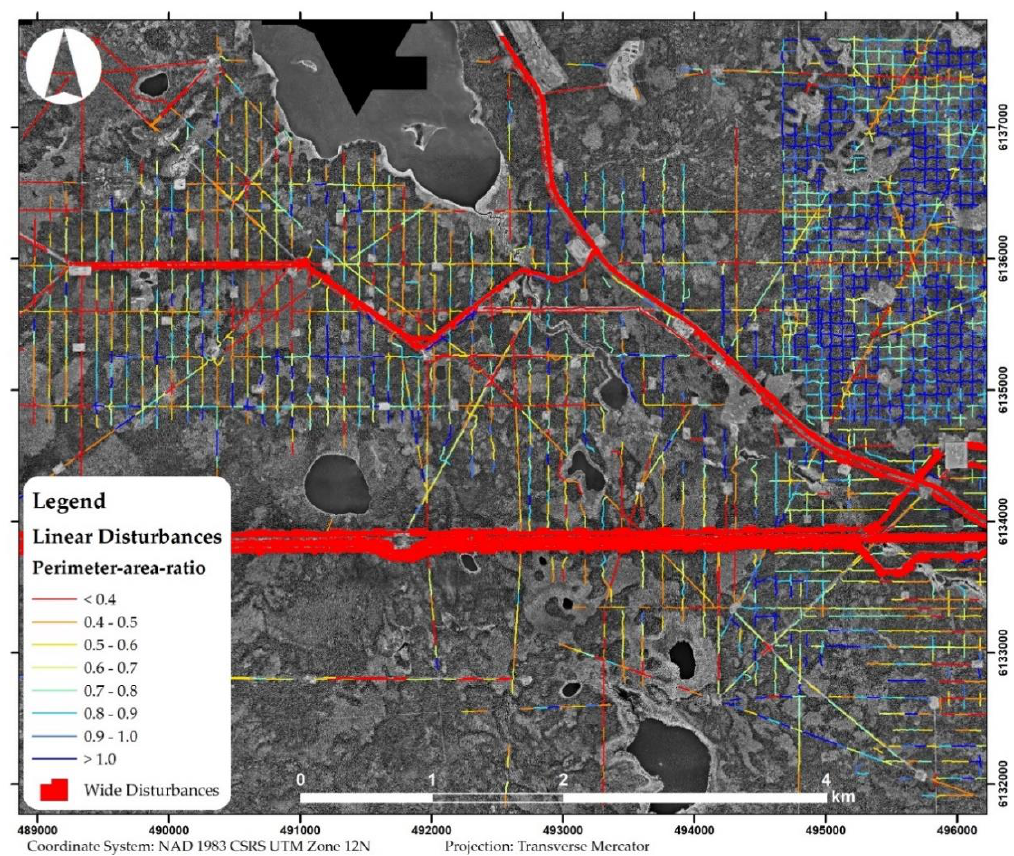
Figure 7. Mapped linear features in Kirby using 25cm pixel-size inputs. Seismic lines are classified by perimeter-area-ratio (PAR). Wide disturbances include roads, pipelines and power lines.